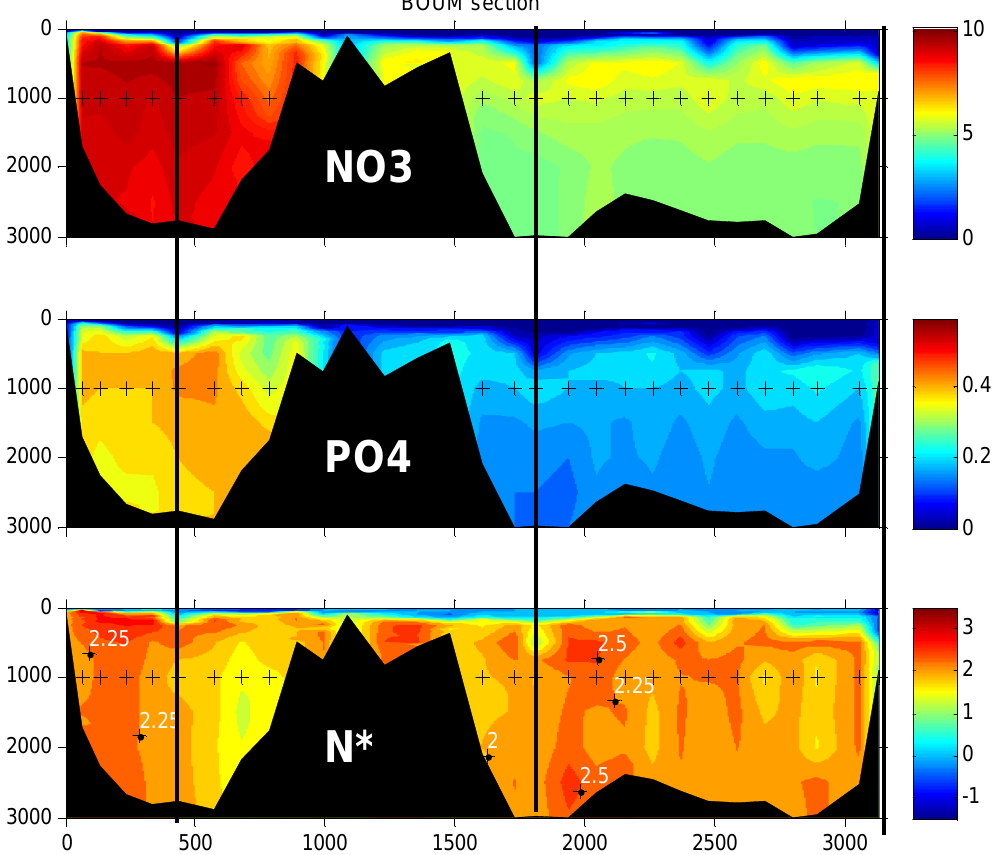
Fig. 5. Nitrate and phosphate concentrations (µM) and N* (µM) sections along the BOUM transect (0–3000dbars). N* = NO 3 –PO 4 *Rr; Rr = 17.7 following Pujo-Pay et al. (2011). Linear interpolation between bottle data each 10dbars was used to generate the distribution maps. Colour intervals were 0.25µM for NO 3 and N* and 0.025µM for PO 4 . Black vertical lines indicate the location of the three LD stations A, B, and C. The x-axis is graduated in km from SD 27 near the mouth of the Rhˆone